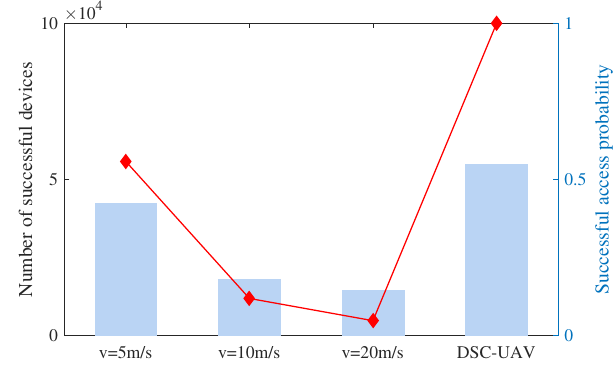
Figure 9. Successful number and